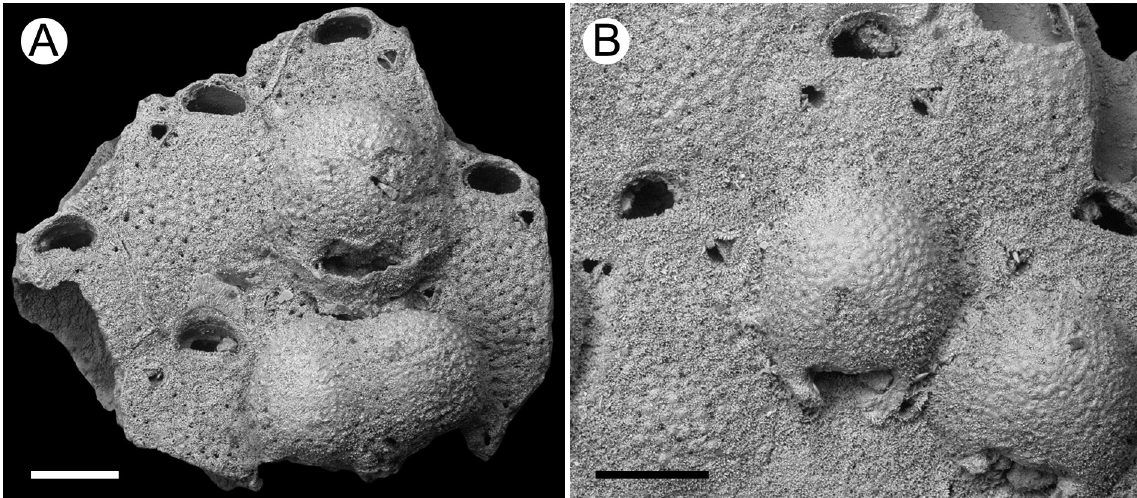
Fig. 6. Microporella hyadesi (Jullien, 1888) sensu Brown 1952 (NHMUK D36796 and D36797), Southland, Waianan, Middle Miocene, base of the uppermost Mt. Brown “E” Limestone, Junction of Weka Creek, Weka Pass Stream, Waipara, Canterbury, New Zealand. Two colony fragments including autozooids and ovicellate zooids. Scale bars = 200